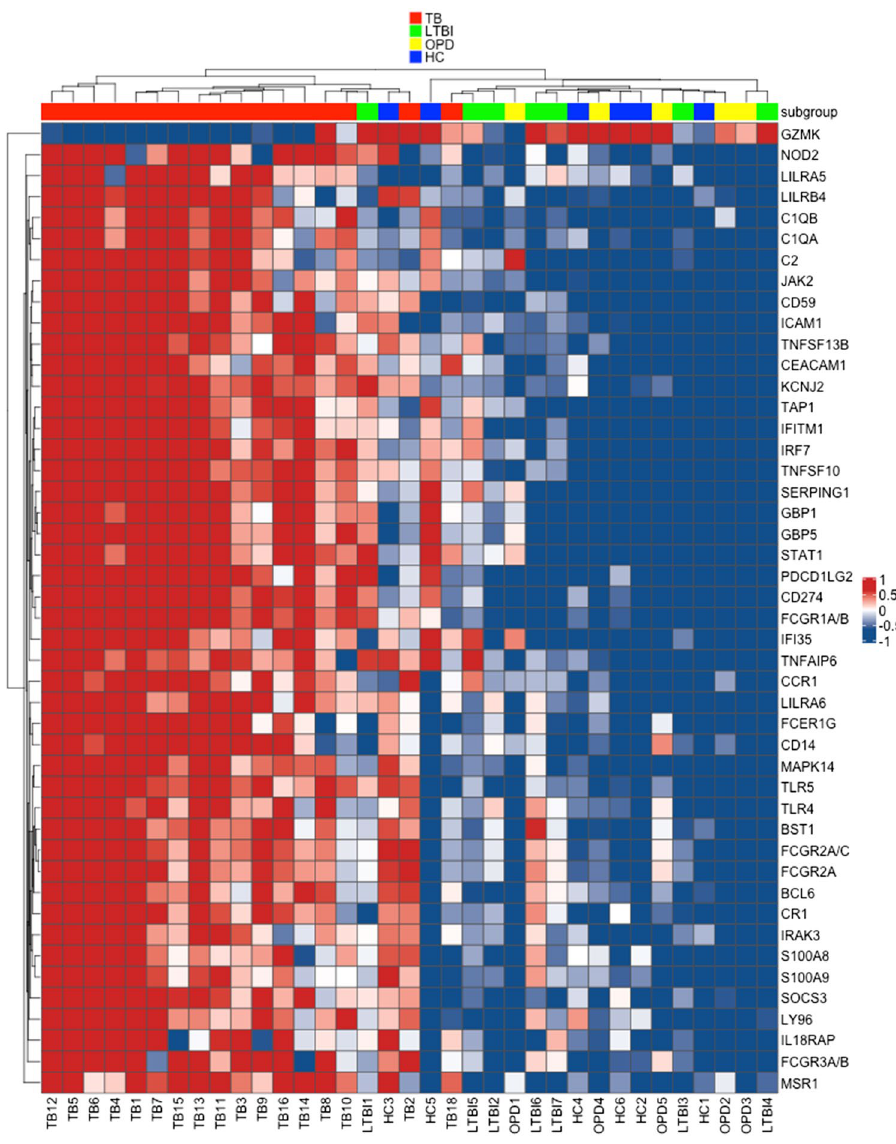
Figure 1. Heatmap showing different expression pattern of 46 proinflammatory genes out of 549 genes. Heatmap of gene expression levels in patients diagnosed with active TB (red), LTBI subjects (green), OPD patients (yellow) and uninfected donors HC (blue). Expression levels are scaled from dark blue (low expression) to dark red (high expression). Heatmap was generated in R (version 3.6.3) with the ComplexHeatmap package (version 2.0.0, https ://bioco nduct or.org/packa ges/relea se/bioc/html/Compl exHea